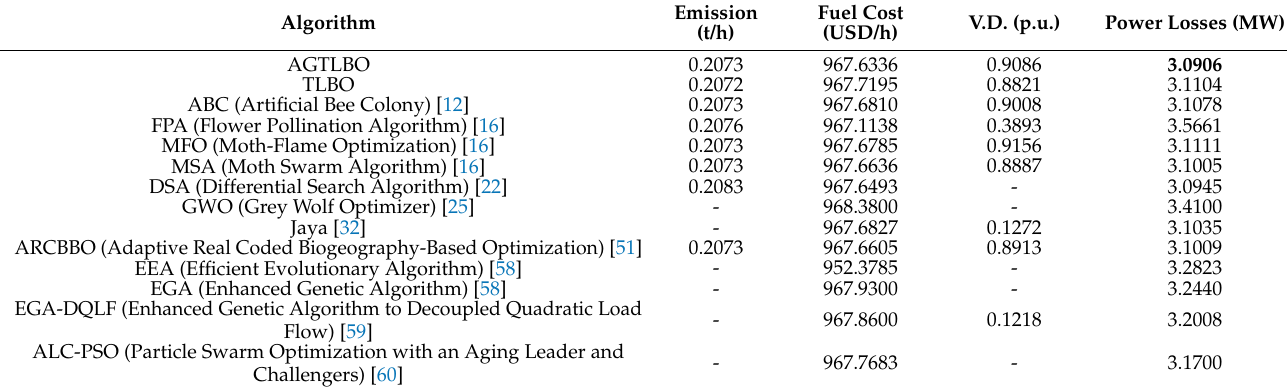
Table 5. Optimal results by different algorithms for Case 4.